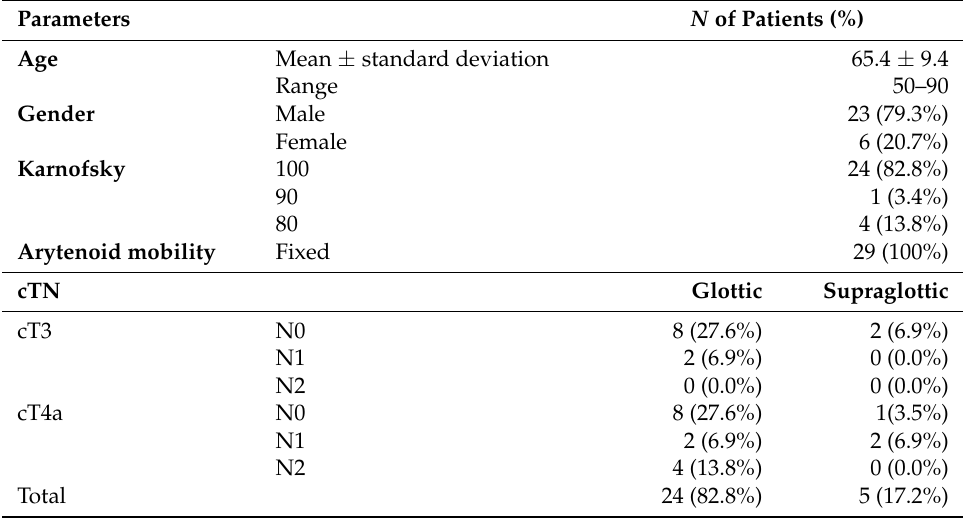
Table 1. Epidemiologic and clinical characteristics of patients treated in the present series ( N = 29); clinical TN classification (cTN) because patients treated only by chemoradiotherapy